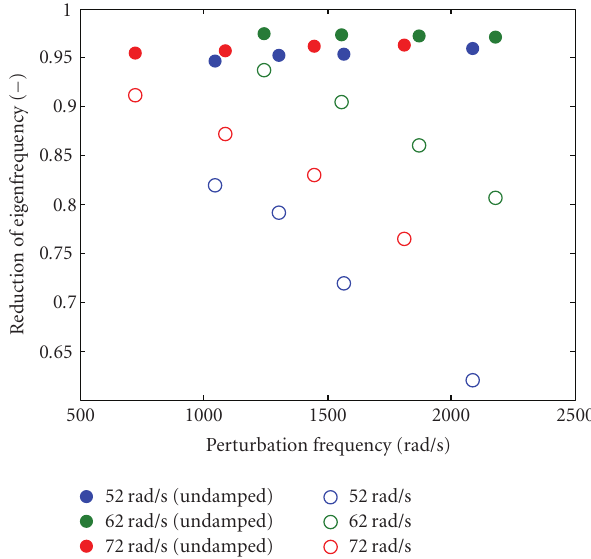
Figure 7: Reduction of the eigenfrequency (the eigenfrequency of the mechanical system is 1) due to the flow through the turbine. The “undamped” markers represent the e ff ect of an added polar inertia alone.